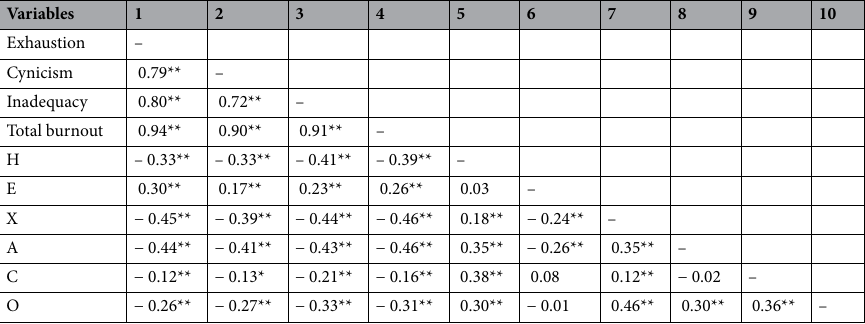
Table 1. Correlation matrix between research variables. **p <